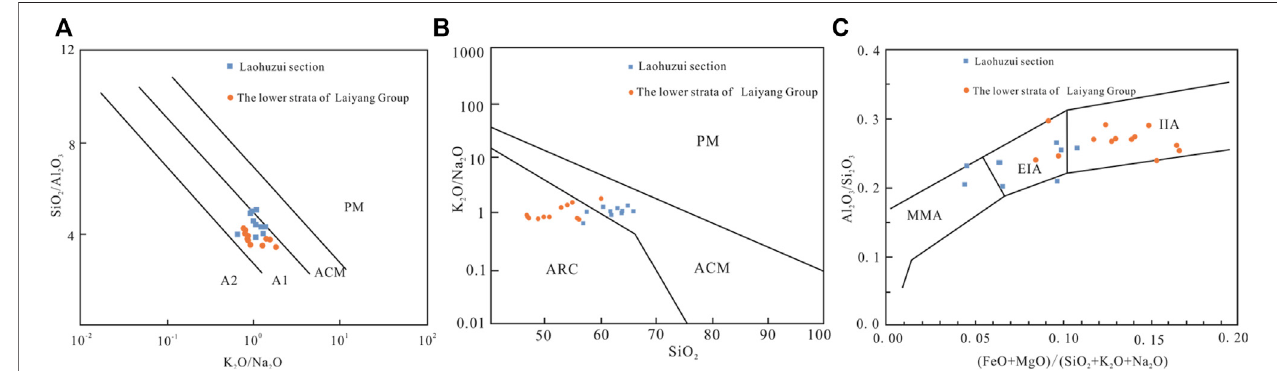
FIGURE 9 | Tectonic setting discrimination diagram of main element provenance of Laohuzui section siltstone. (A) K 2 O/Na 2 O – SiO 2 /Al 2 O 3 discrimination diagram for provenance tectonic setting of siltstones in the Lingshan Island, after Maynard et al. (1982); (B) SiO 2 – K 2 O/Na 2 O discrimination diagram for provenance tectonic settingofsiltstonesinLingshanIsland,afterRoserandKorsch(1986); (C) tectonicsettingdiscriminationdiagramsofAl 2 O 3 /SiO 2 -(FeO+MgO)/(SiO 2 +K 2 O+Na 2 O),after Kumon and Kiminami (1994) (ARC: oceanic island arc; ACM: active continental margin; PM: passive continental margin; A1: island arc of basaltic and andesitic detrital; A2: evolved island arc of intrusive felsic rock detrital; IIA: immature island arc; EIA: evolved island arc; and MMA: mature magmatic